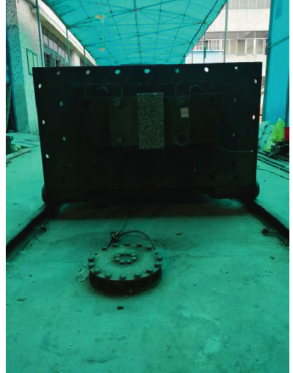
Figure 5: Vertical drop hammer.